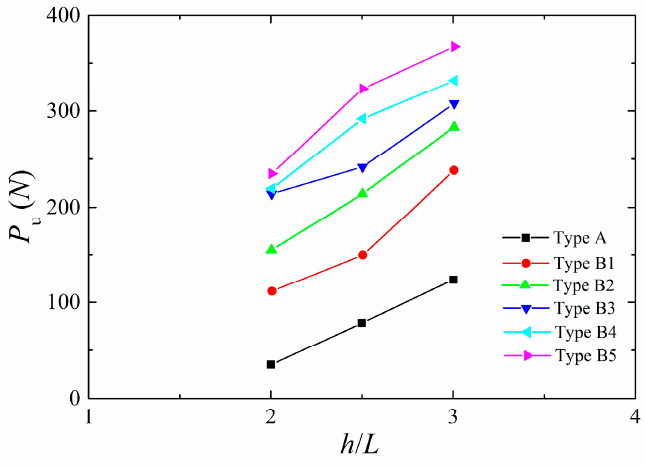
Figure 7. P – h curves of the TAs under vertical pullout loading.